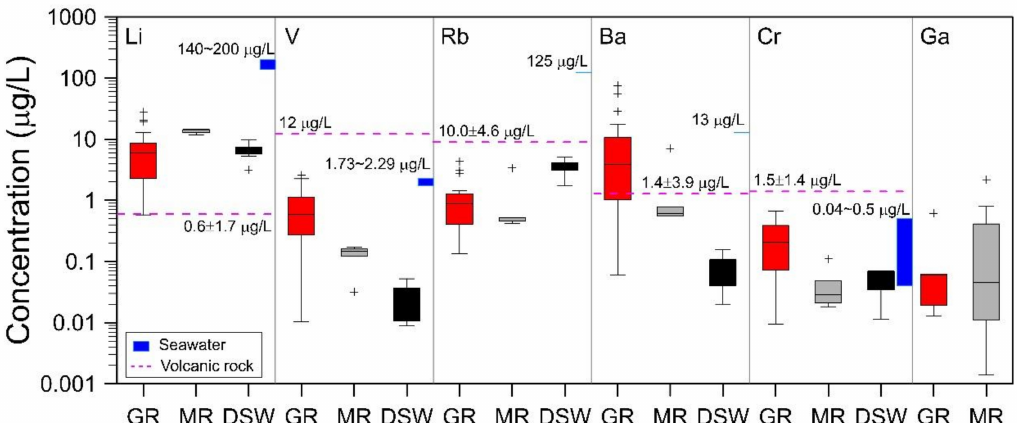
Figure 4. Box-whisker diagram showing concentration of some trace elements of Korean bottled water originating from di ff erent lithological units and seawater. GR, MR, and DSW represent granitic rock, metamorphic rock, and desalinated water, respectively. Please see the text for literatures regarding concentration of trace elements in seawater and volcanic